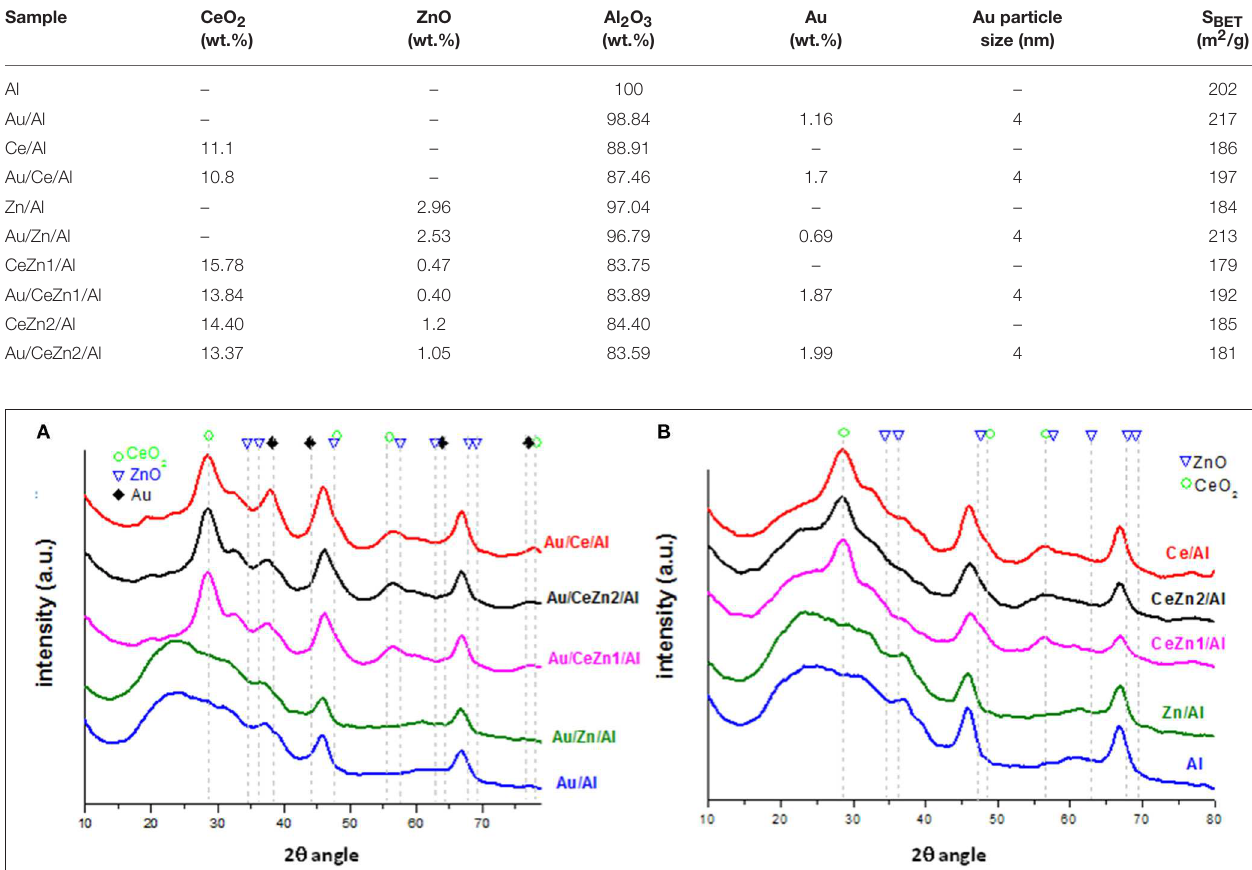
TABLE 2 | Chemical compositions and specific surface area of the prepared Zn promoted solids. Sample